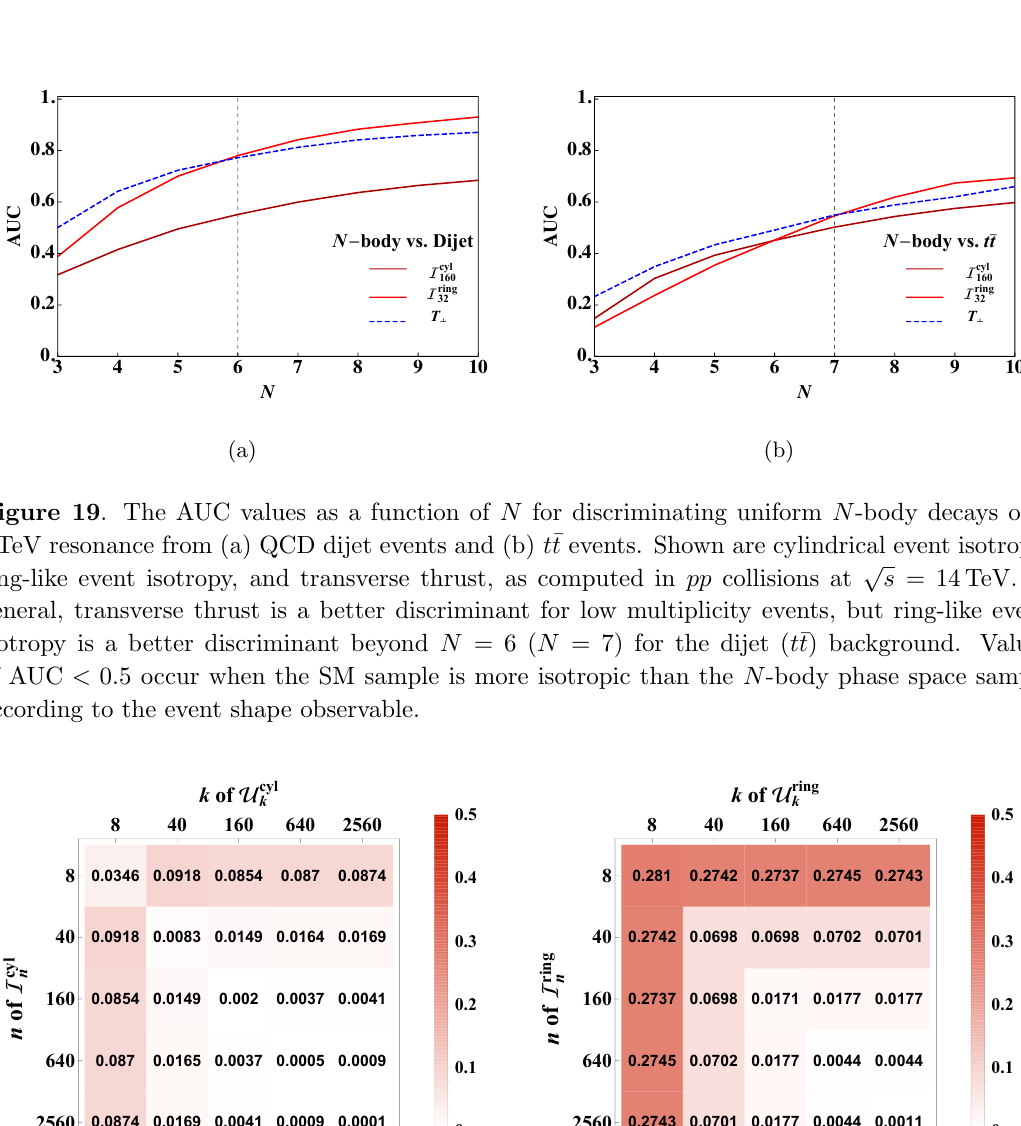
computed on ring-like n